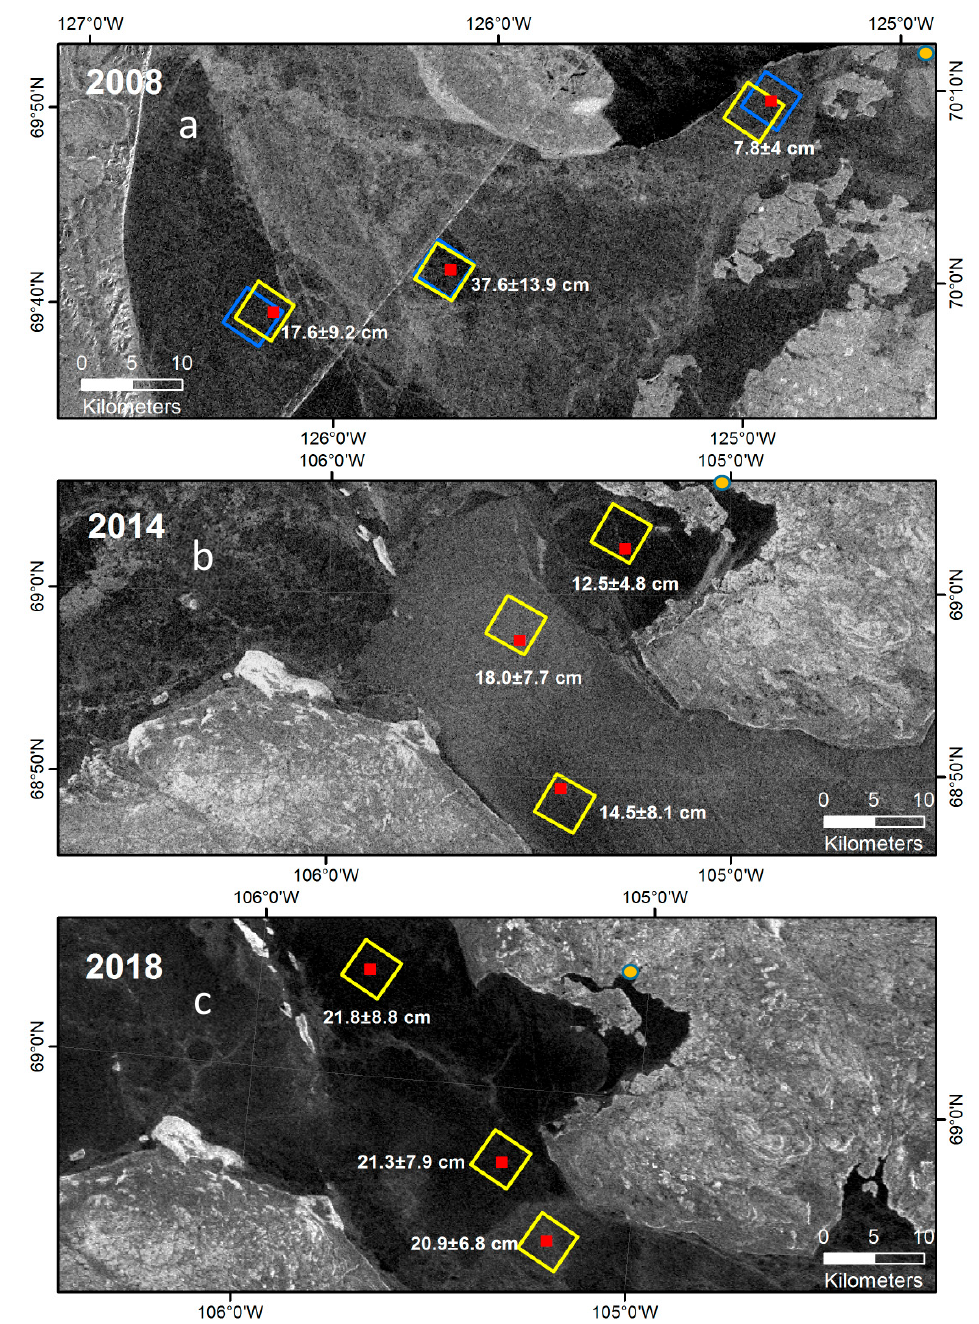
Figure 1. Franklin Bay [2008] and Cambridge Bay [2014 and 2018] case study locations on landfast first-year sea ice in the western Canadian Arctic Archipelago.